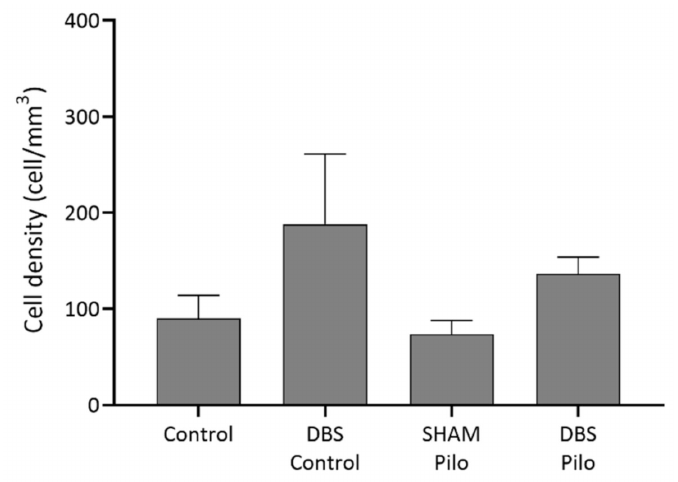
Figure 5. PV+/NPY+ cell density in the CA1 subregion of the hippocampus. No significant differ- ences were observed among the groups. The density was higher in the DBS groups, but the difference was not significant, and the density of this cell type was very low compared to other cell types. Data are presented as means ± SEM.